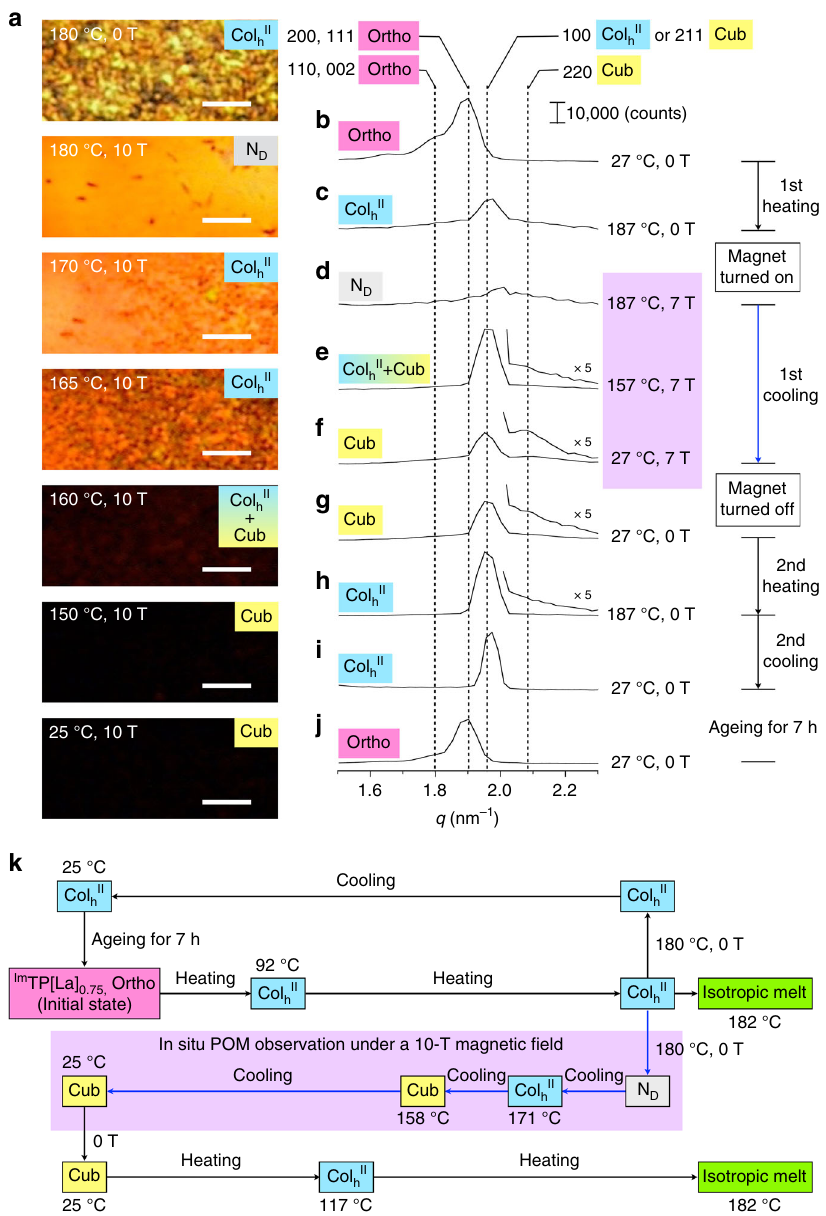
Fig. 3 In situ observations of the phase behaviour of Im TP[La] 0.75 under a strong magnetic fi eld. a POM micrographs of a fi lm of Im TP[La] 0.75 on a glass substrate observed at 180 °C ( fi rst heating; heating rate: 20 °C/min) in the absence of a magnetic fi eld, and observed at 180, 170, 165, 160, 150 and 25 °C upon cooling (cooling rate ≤ 0.5 °C/min) in a 10-T magnetic fi eld. Scale bars, 200 µ m. b – j X-ray diffraction patterns of the small-angle region (scattering vector q = 1.5 – 2.3 nm − 1 ) of a bulk sample of Im TP[La] 0.75 in a glass capillary (diameter: 2.5 mm) measured at 27 °C ( b ) and 187 °C ( c ) upon fi rst heating (heating rate: 20 °C/min) in the absence of a magnetic fi eld, measured at 187 °C ( d ), 157 °C ( e ) and 27 °C ( f ) upon fi rst cooling from 187 °C (cooling rate: upon second cooling (cooling rate: 0.5 °C/min) in the absence of a magnetic fi eld. In ( j ), the measurement was conducted after ageing for 7 h at 27 °C. Ortho orthorhombic, Col h hexagonal columnar, N D discotic nematic, Cub cubic, a.u. arbitrary unit. Indices of the re fl ections are shown at the top of the X- ray diffraction peaks. k Schematic representation of the phase-transition behaviour of Im TP[La] 0.75 upon thermal processing in the absence or presence of a 10-T magnetic fi eld. The phase-transition temperatures were determined based on POM observations in the absence or presence of the magnetic fi